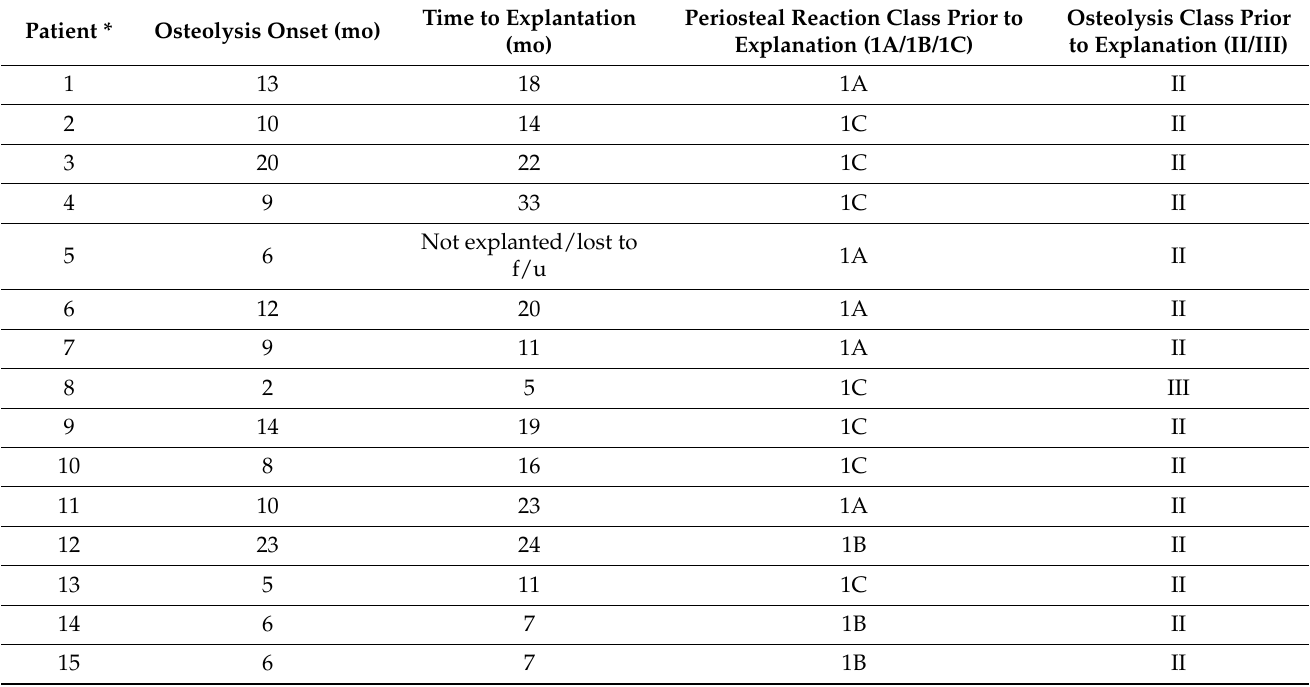
Table 2. Adverse Tissue Reaction (ATR) Pre-Explantation.